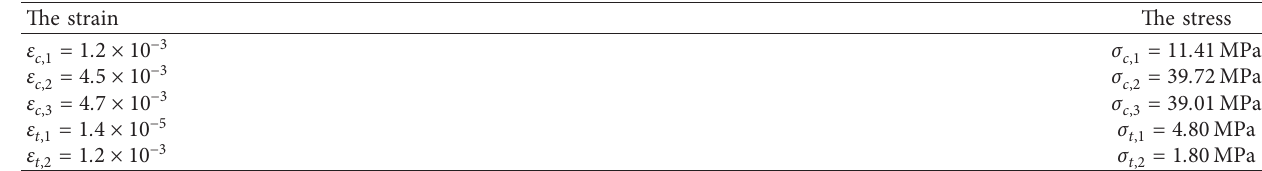
Table 4: Simplified model parameters of reinforced concrete